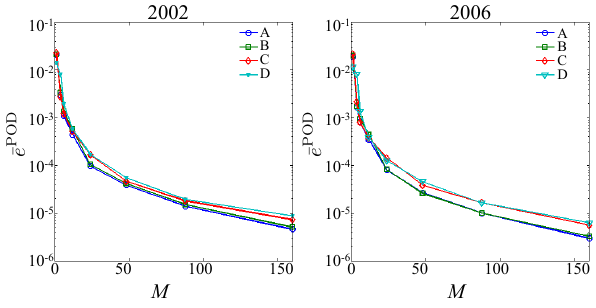
Figure 11. The variation of mean POD-MM2 error ( ¯ e POD - MM2 with respect to M for different 1x g at sites A and D in 2006. Re- sults are shown for single-site ROM constructed using POD-MM2 method.